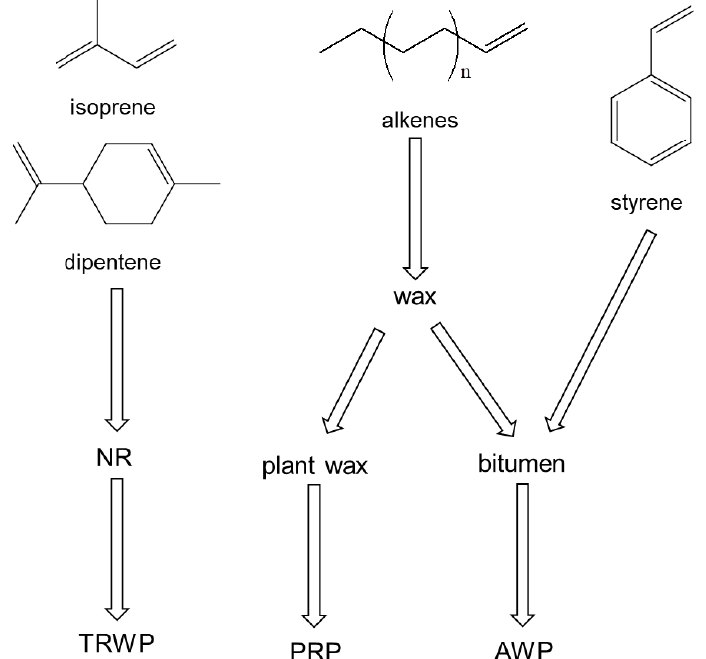
Figure 5. Sources of the principal pyrolysis products obtained from the PM 10 sample.